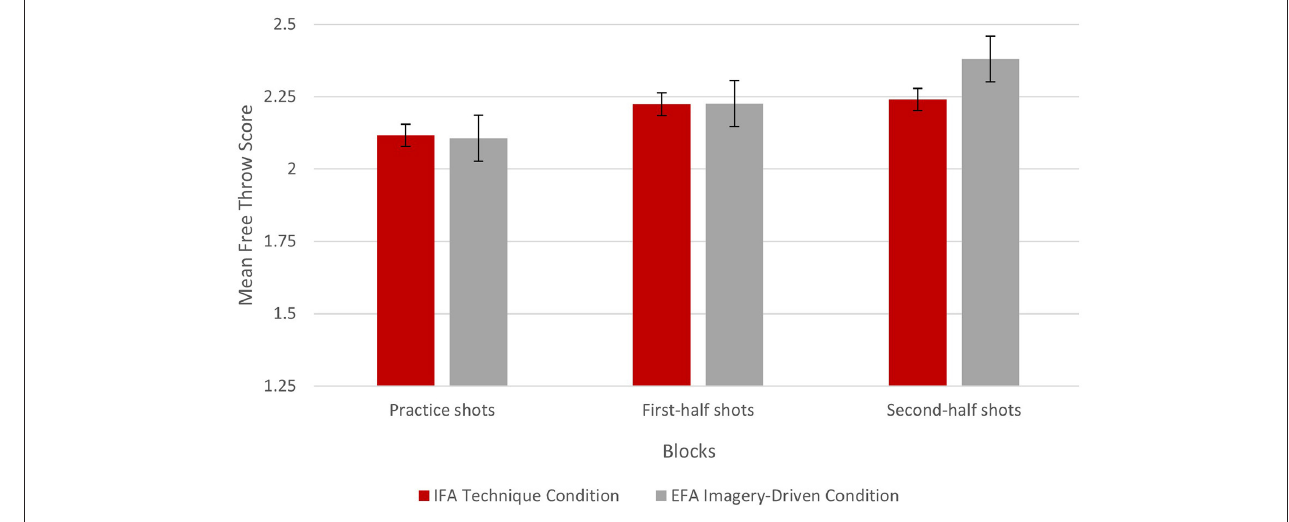
FIGURE 1 | Mean free-throw scores across blocks and